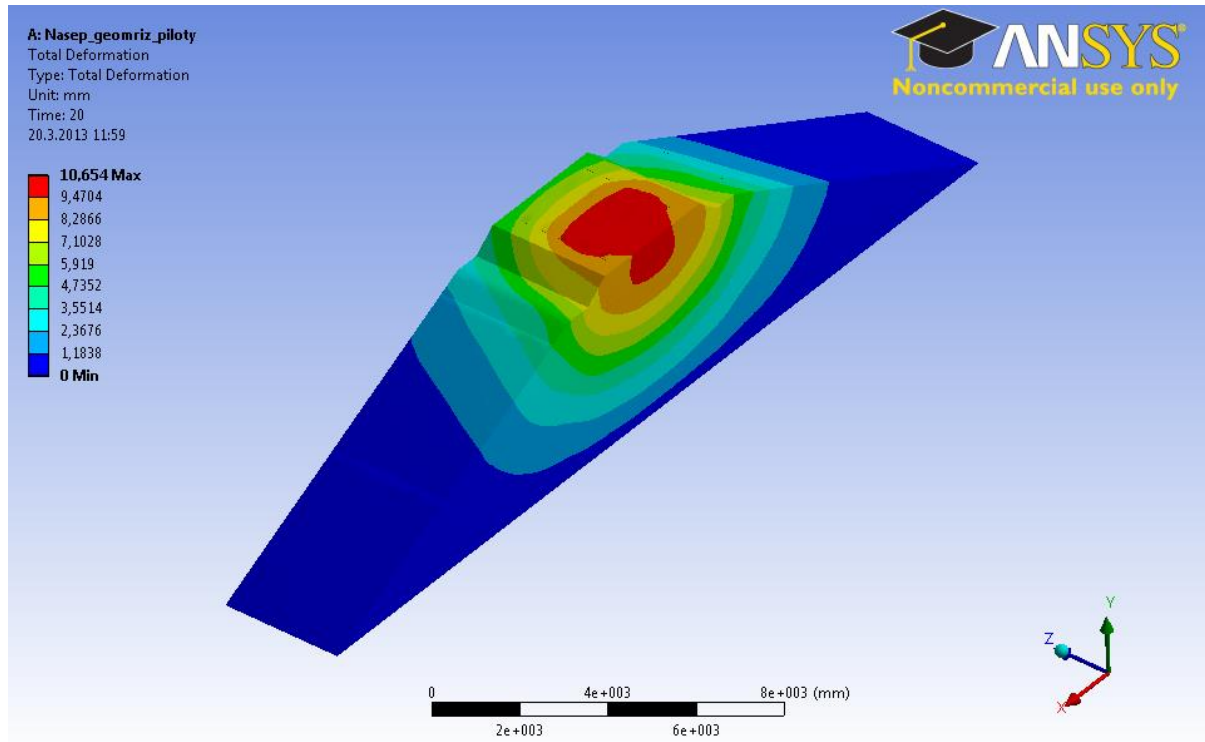
Figure 11. Total deformation of the embankment reinforced by the geogrid and the columns.